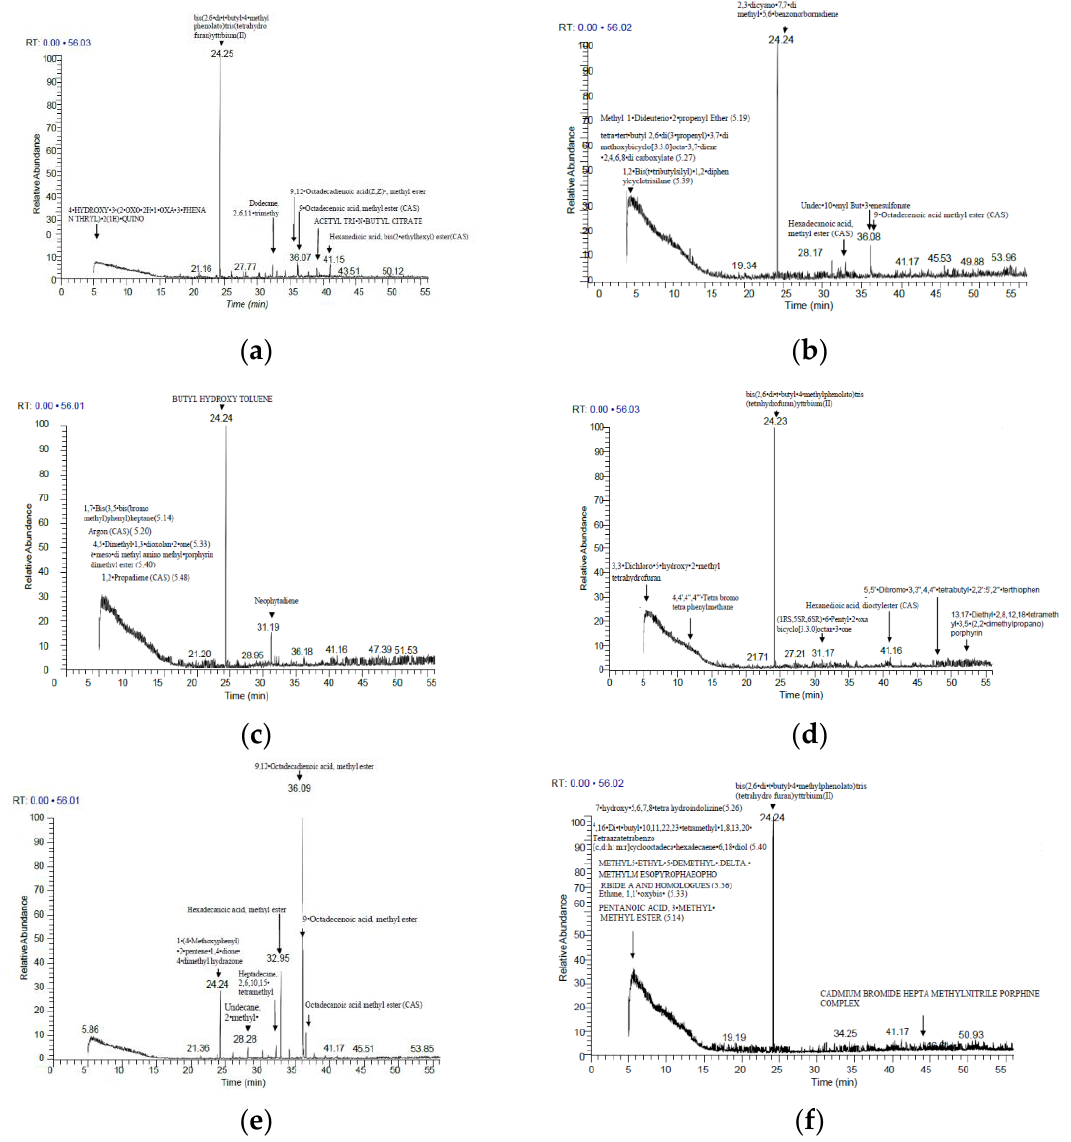
Figure 7. Chromatograms generated by gas chromatography-mass spectrometry (GC/MS) analysis which demonstrates metabolite profiling of Punica granatum leaves of the following treatments: ( a ) Control; ( b ) NPK; ( c ) nHAP_PPE50; ( d ) nHAP_PPE1000; ( e ) nHAP_CE50; ( f ) nHAP_CE1000.